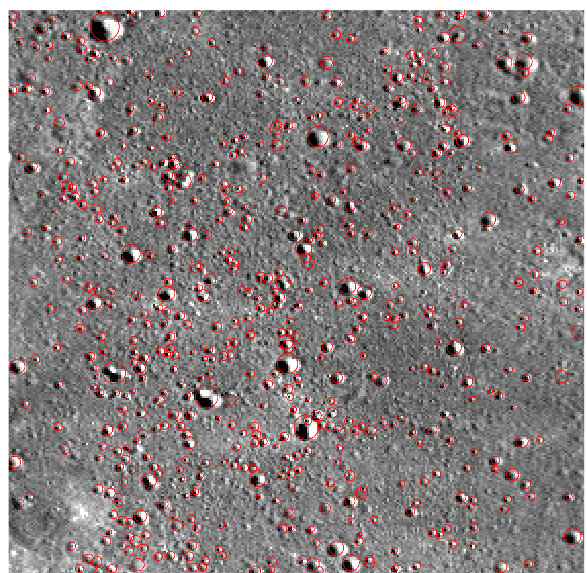
Figure 4. The detection result of craters (diameter